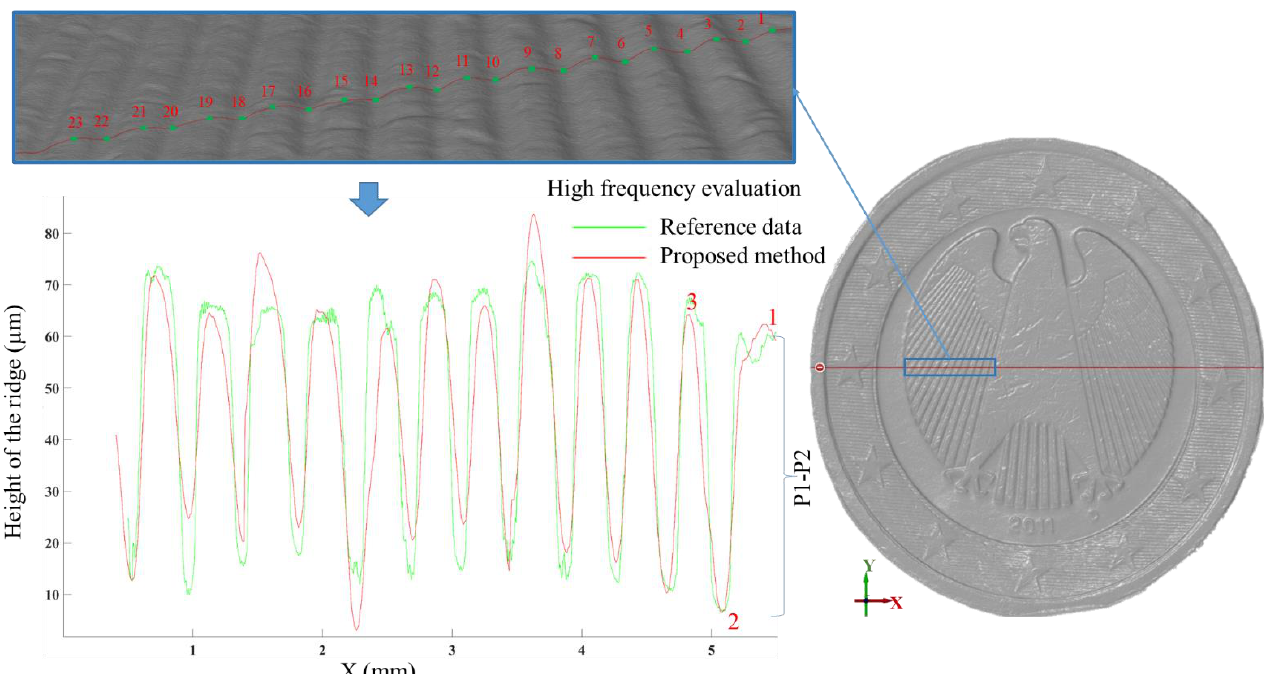
Figure 14. High resolution evaluation between the profiles measured with the profilometer in green and the proposed method in red for object E. Table 2. The estimated residuals of the ridge height ( µ m) between the proposed method and reference data from point 1 to point 13.